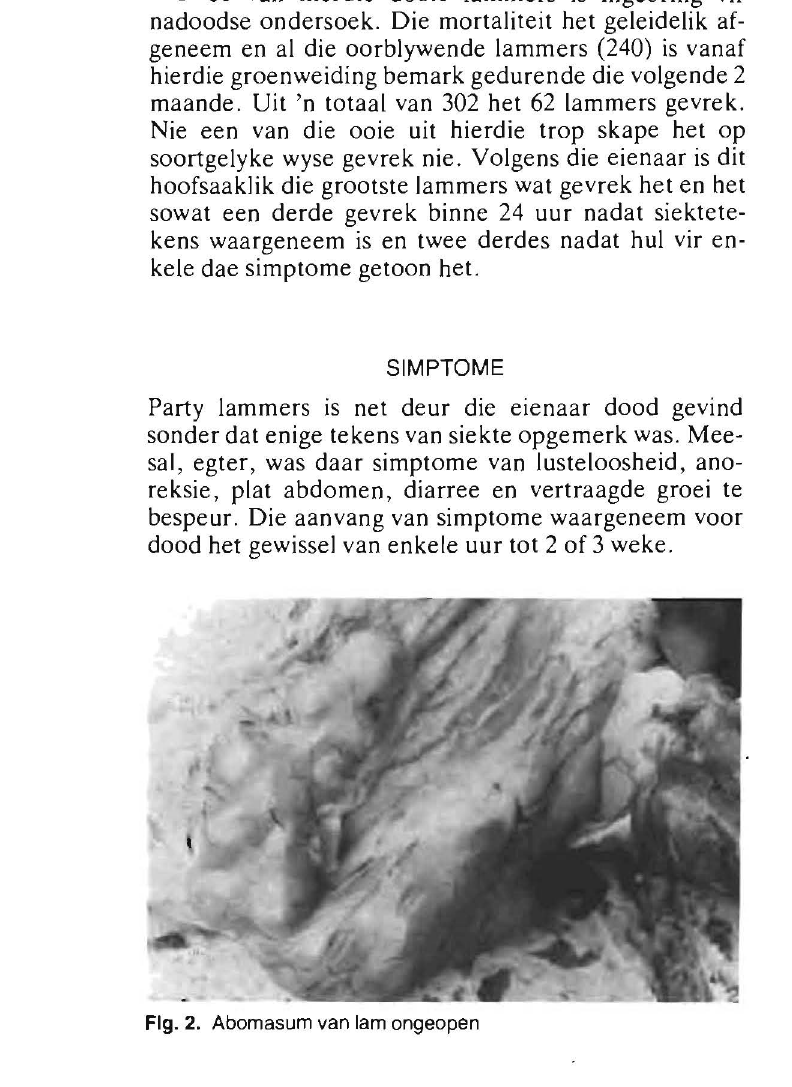
Fig. 2. Abomasum van lam ongeopen Fig. 3. Abomosum van lam